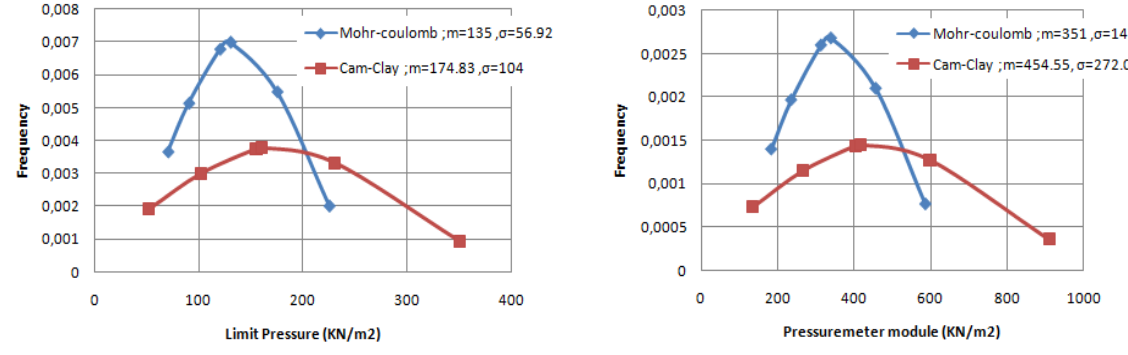
Fig.6. Dispersion of the Limit Pressure Fig.7. Dispersion of the pressuremeter module Correlations between the limit pressure and the pressuremeter module.